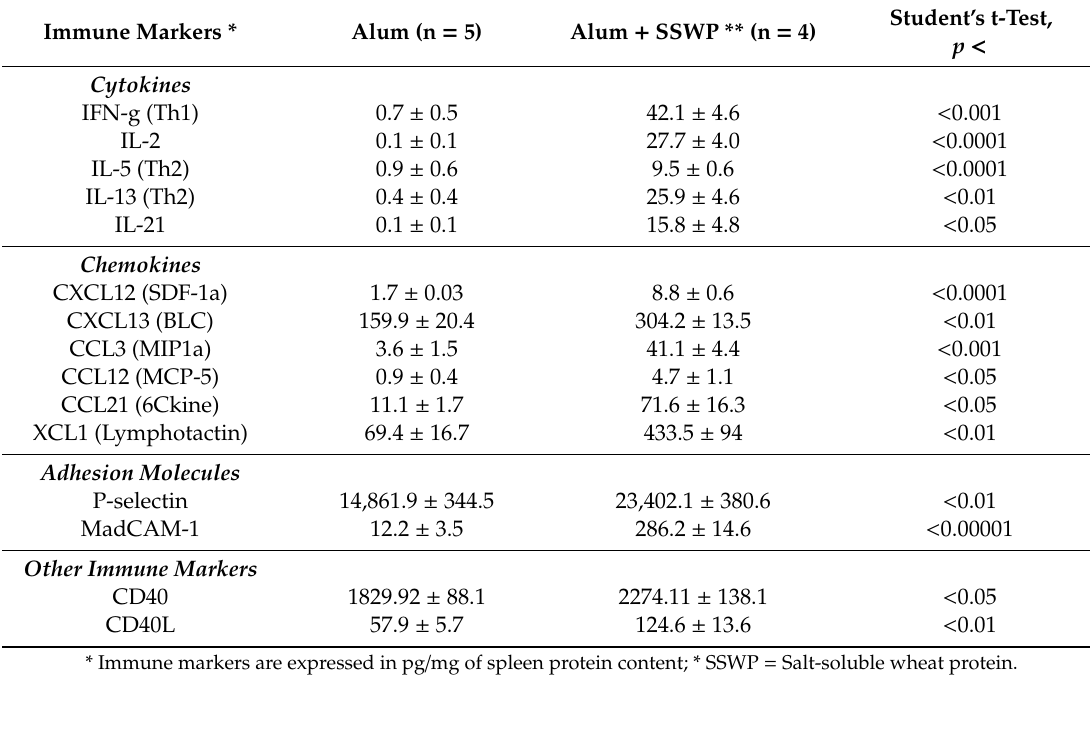
Table 3. Identification of in vivo immune markers for intrinsic wheat protein allergenicity in an alum-adjuvant mouse model.